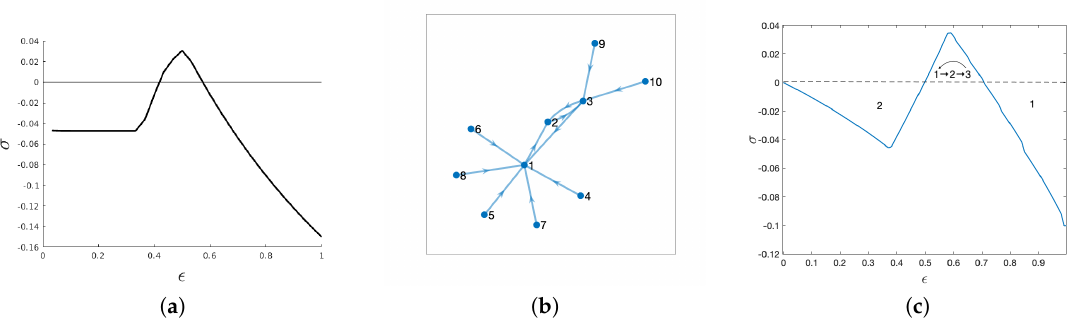
Figure 4. ( a ) Intransitiveness index σ vs absorbency (cid:101) for a scale-free network with 100 nodes as a function of the absorbency parameter ε . There is intransitive behaviour for intermediate values of this parameter. ( b ) The small subnet presumably responsible for the the intransitive region σ > 0 ( c ) Intransitiveness index σ vs absorbency (cid:101) for this